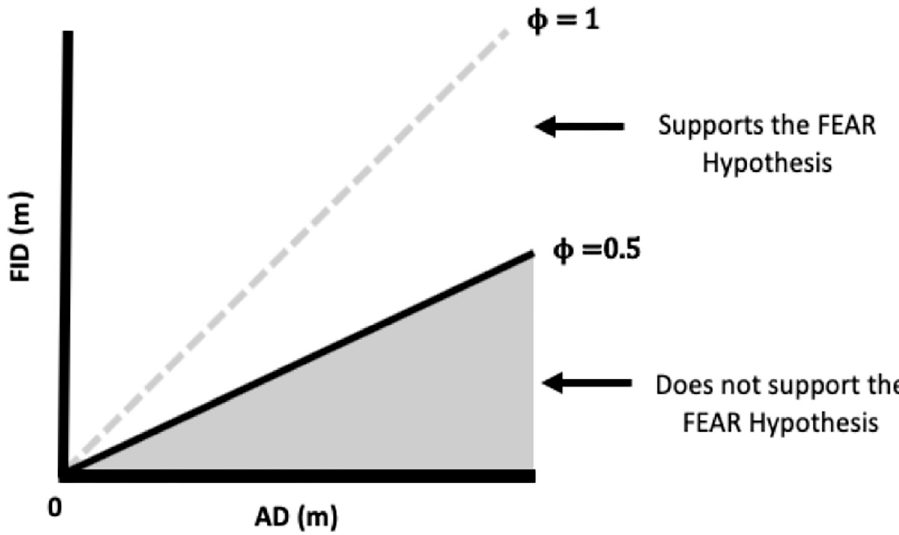
Fig 3. Illustration of the relationship between AD and FID according to the FEAR Hypothesis’s phi index. The range of ϕ is between 0 and 1. A ϕ value of 0 occurs when animals do not escape at all even after detection and a ϕ value of 1 occurs when prey escape the moment it detects the predator. ϕ must be greater than 0.5 to support the FEAR hypothesis (Samia & Blumstein 2014) [44].